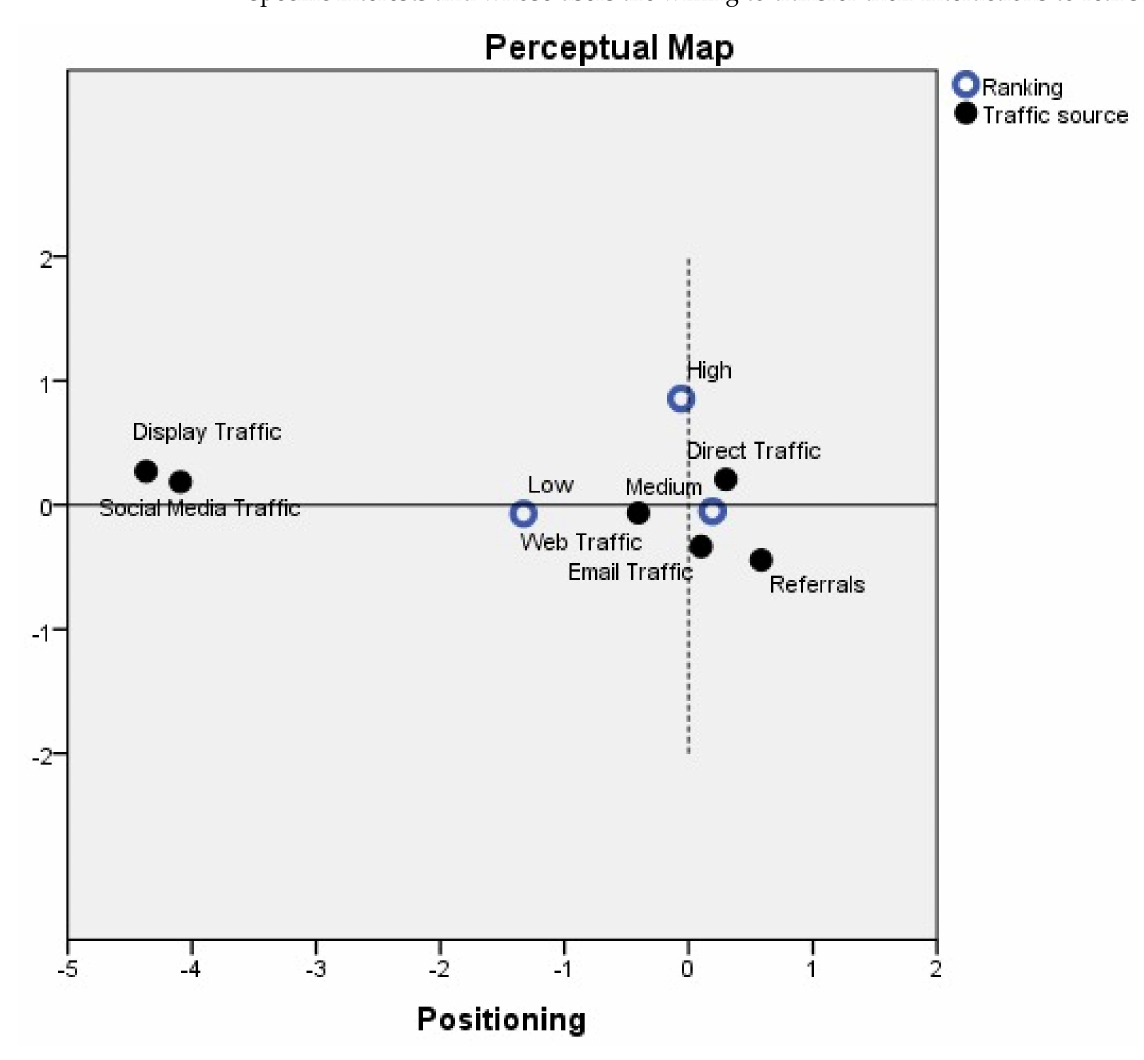
Figure 7. Correspondence analysis between positioning and web traffic source. Note: constructed from consolidated and weighted data from the Similarweb